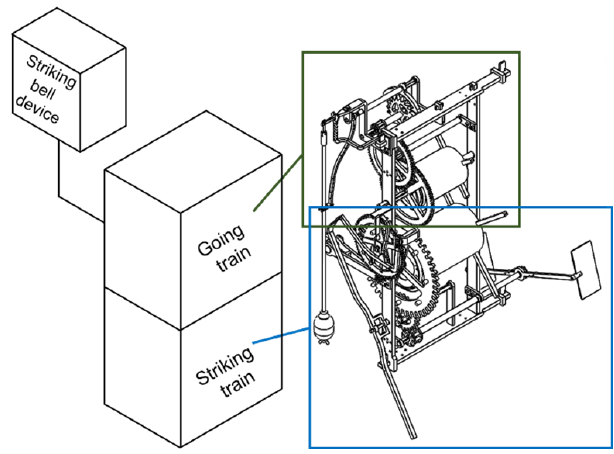
Figure 6. Structure of the Castle Combe clock